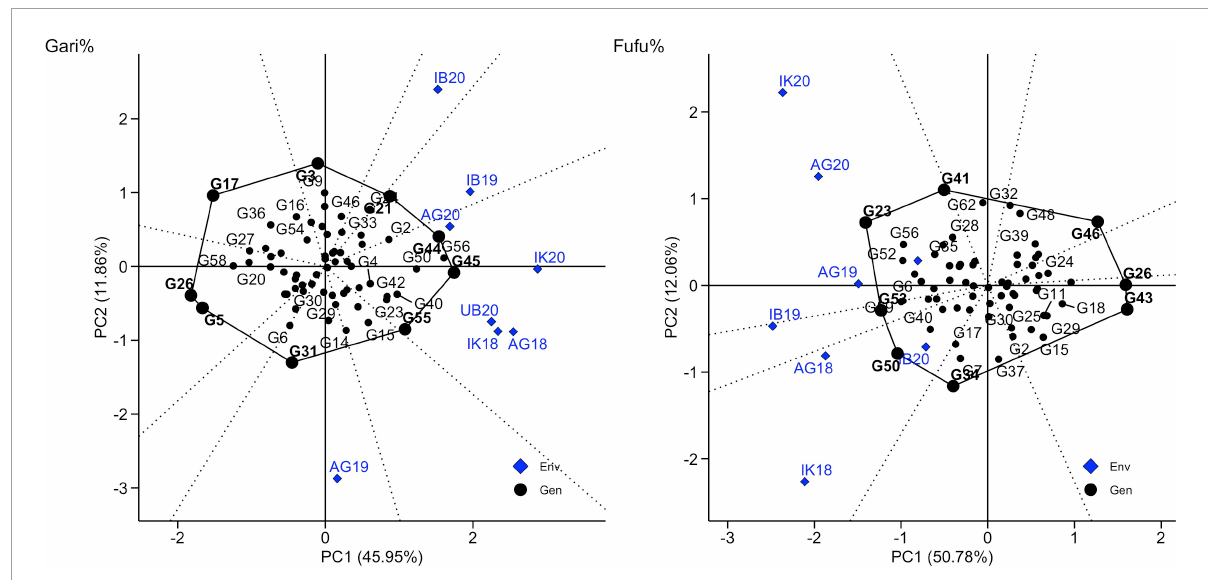
FIGURE7 Vector views of PC2 are plotted against PC1 for environment relations, winning genotypes, and environment